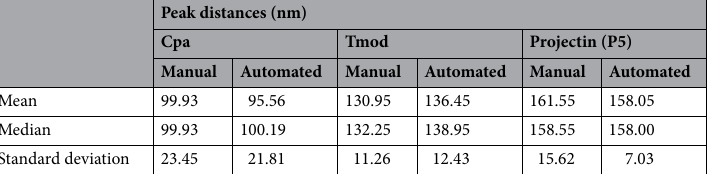
Table 2. Statistical characteristics of the distribution of relative protein positions ( Cpa Capping protein alpha, Tmod Tropomodulin and Projectin (P5)) determined by IFM-Analyser for manual and automated